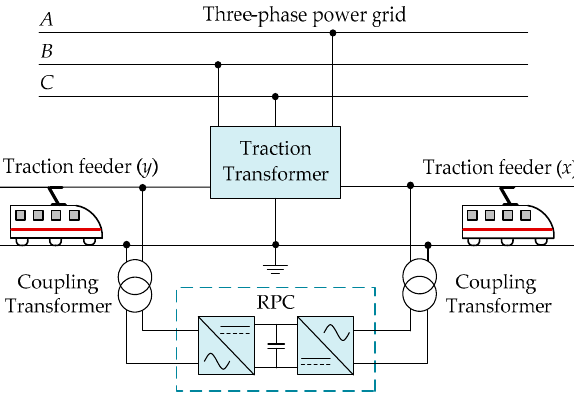
Figure 1. FB-RPC system linked to a single-phase traction power grid (based on [6]).